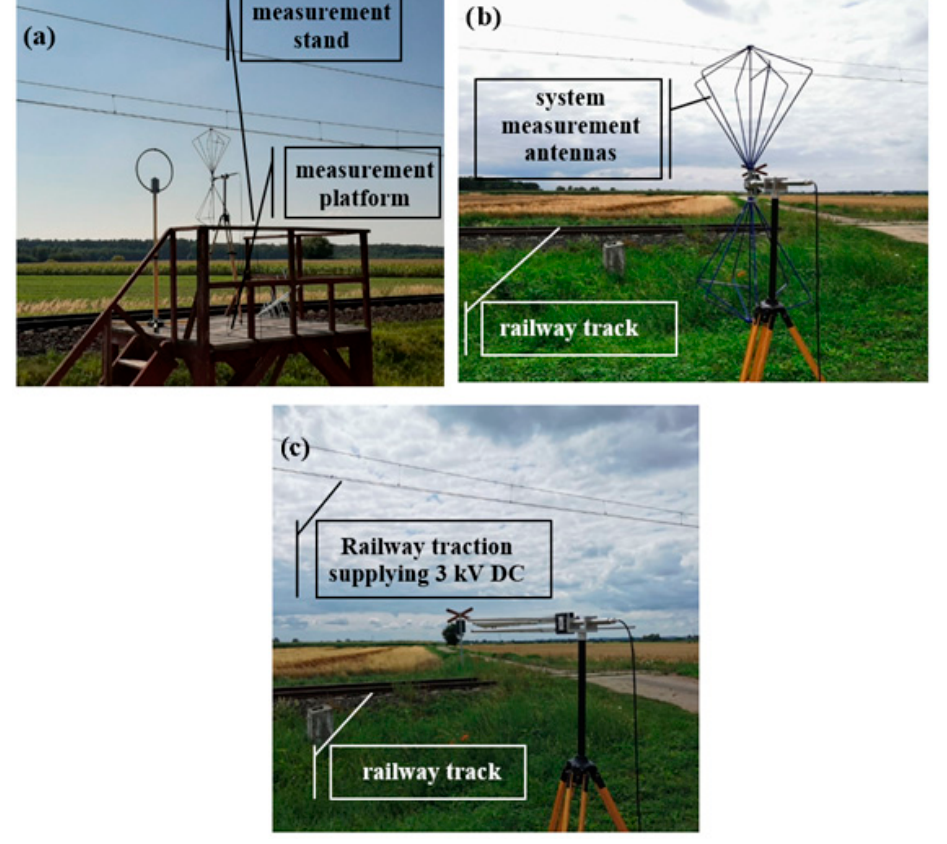
Figure 8. Appearance of actual measurement stands located within the Railway Institute Test Track for various types of measuring antennas.